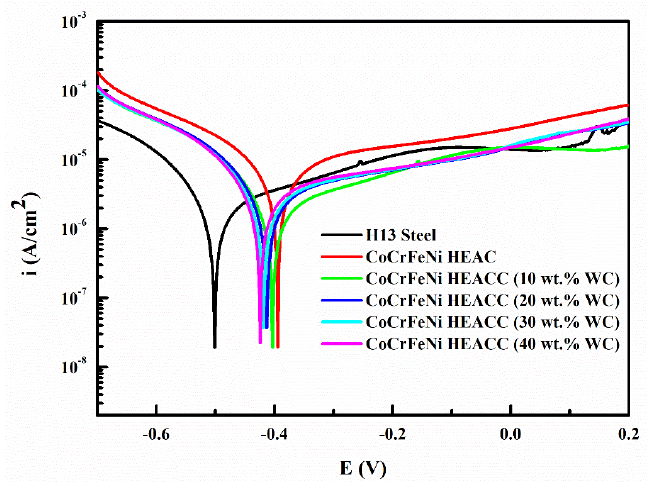
Figure 11. Polarization curve of H13 steel substrate (black) and coatings on H13 steel: CoCrFeNi HEAC (red); CoCrFeNi HEACC (10 wt.% WC: green); CoCrFeNi HEACC (20 wt.% WC: blue); CoCrFeNi (30 wt.%WC: cyan); CoCrFeNi HEACC (40 wt.% WC: purple). Table 5. Corrosion dynamics parameters for the materials.